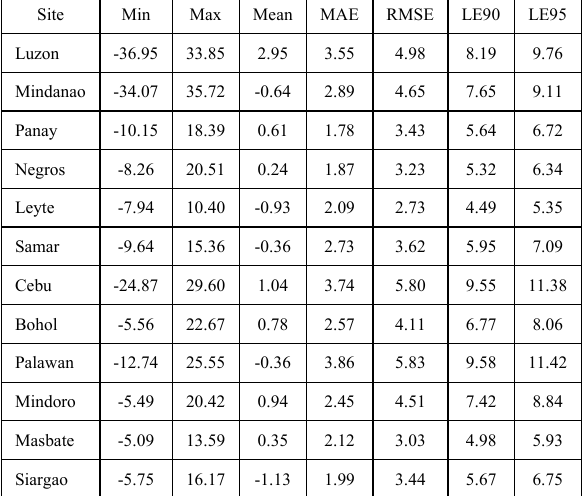
Table 5. Statistics of the FABDEM errors when evaluated in selected islands of the Philippines. The values are the average of the results using the three sets of GCPs (unit: meters).